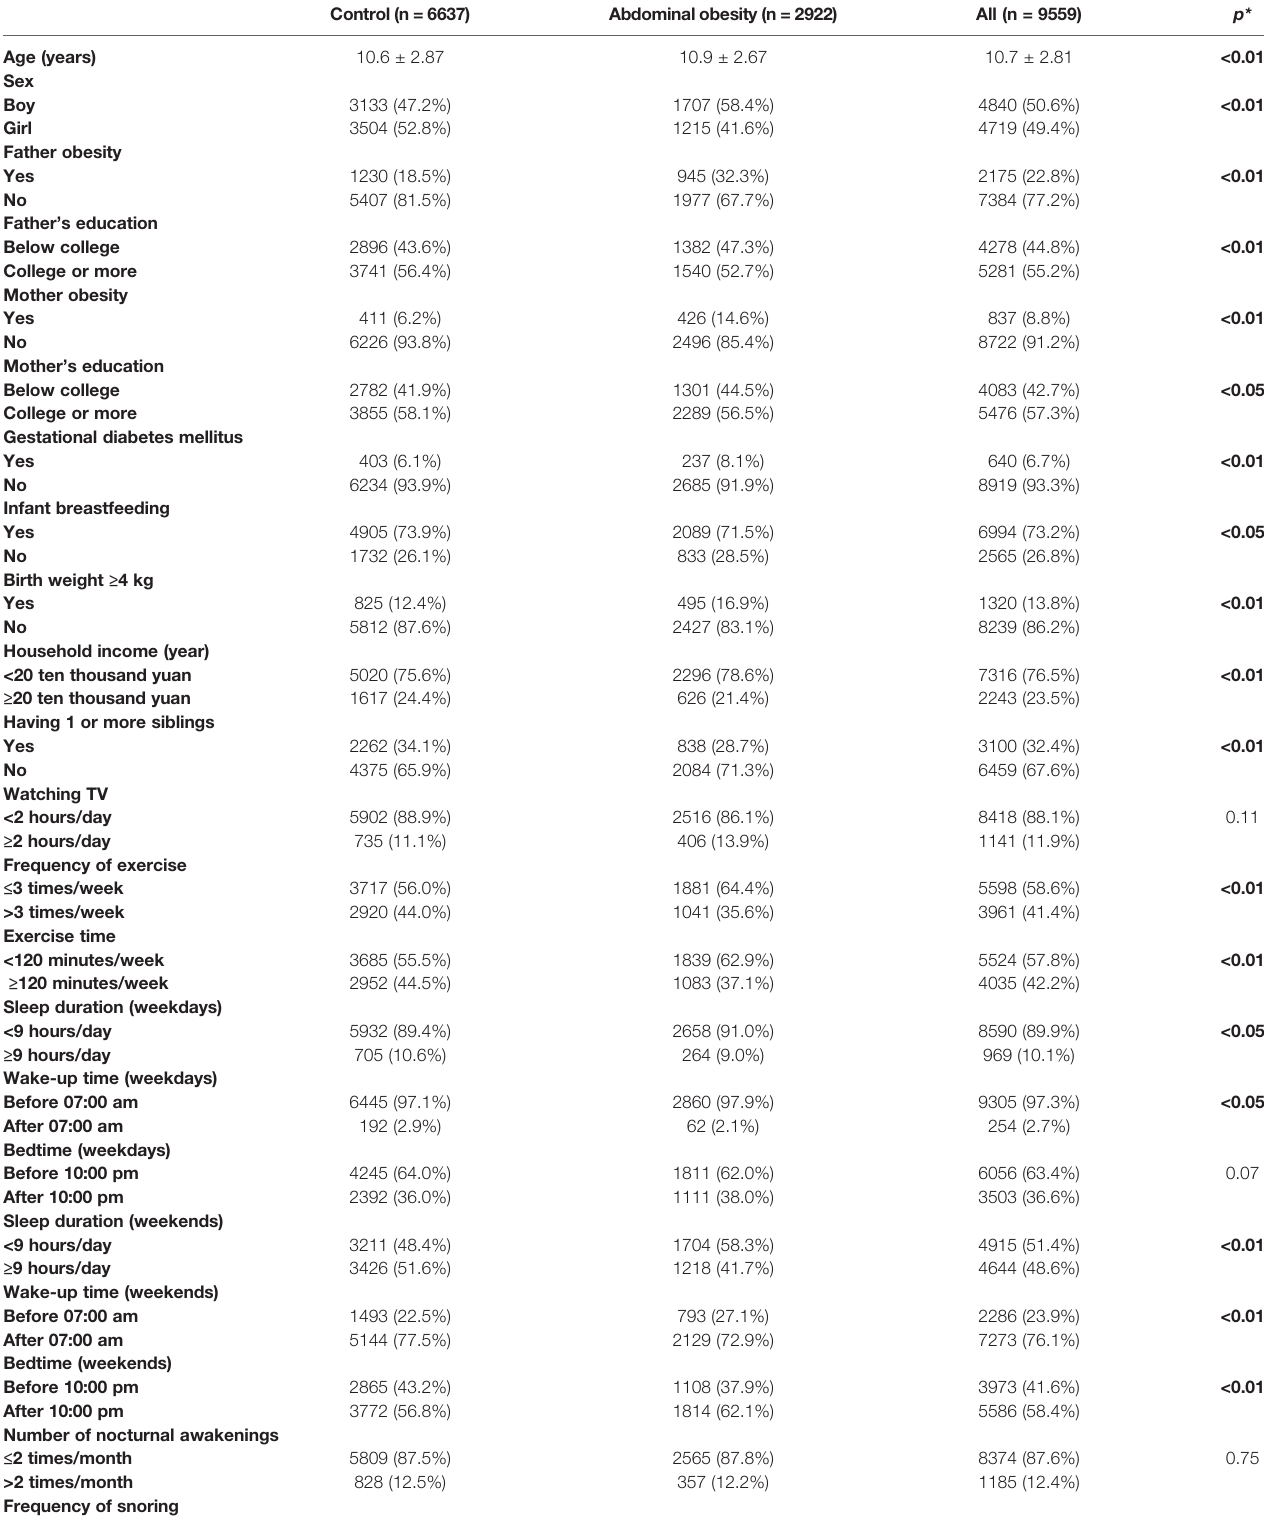
TABLE 1 | Baseline characteristics of study